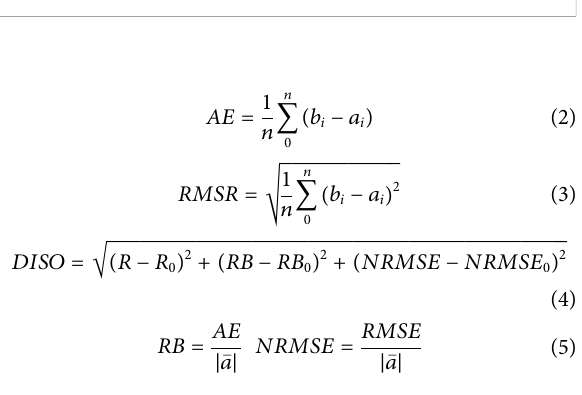
Classi fi cation of land cover in the